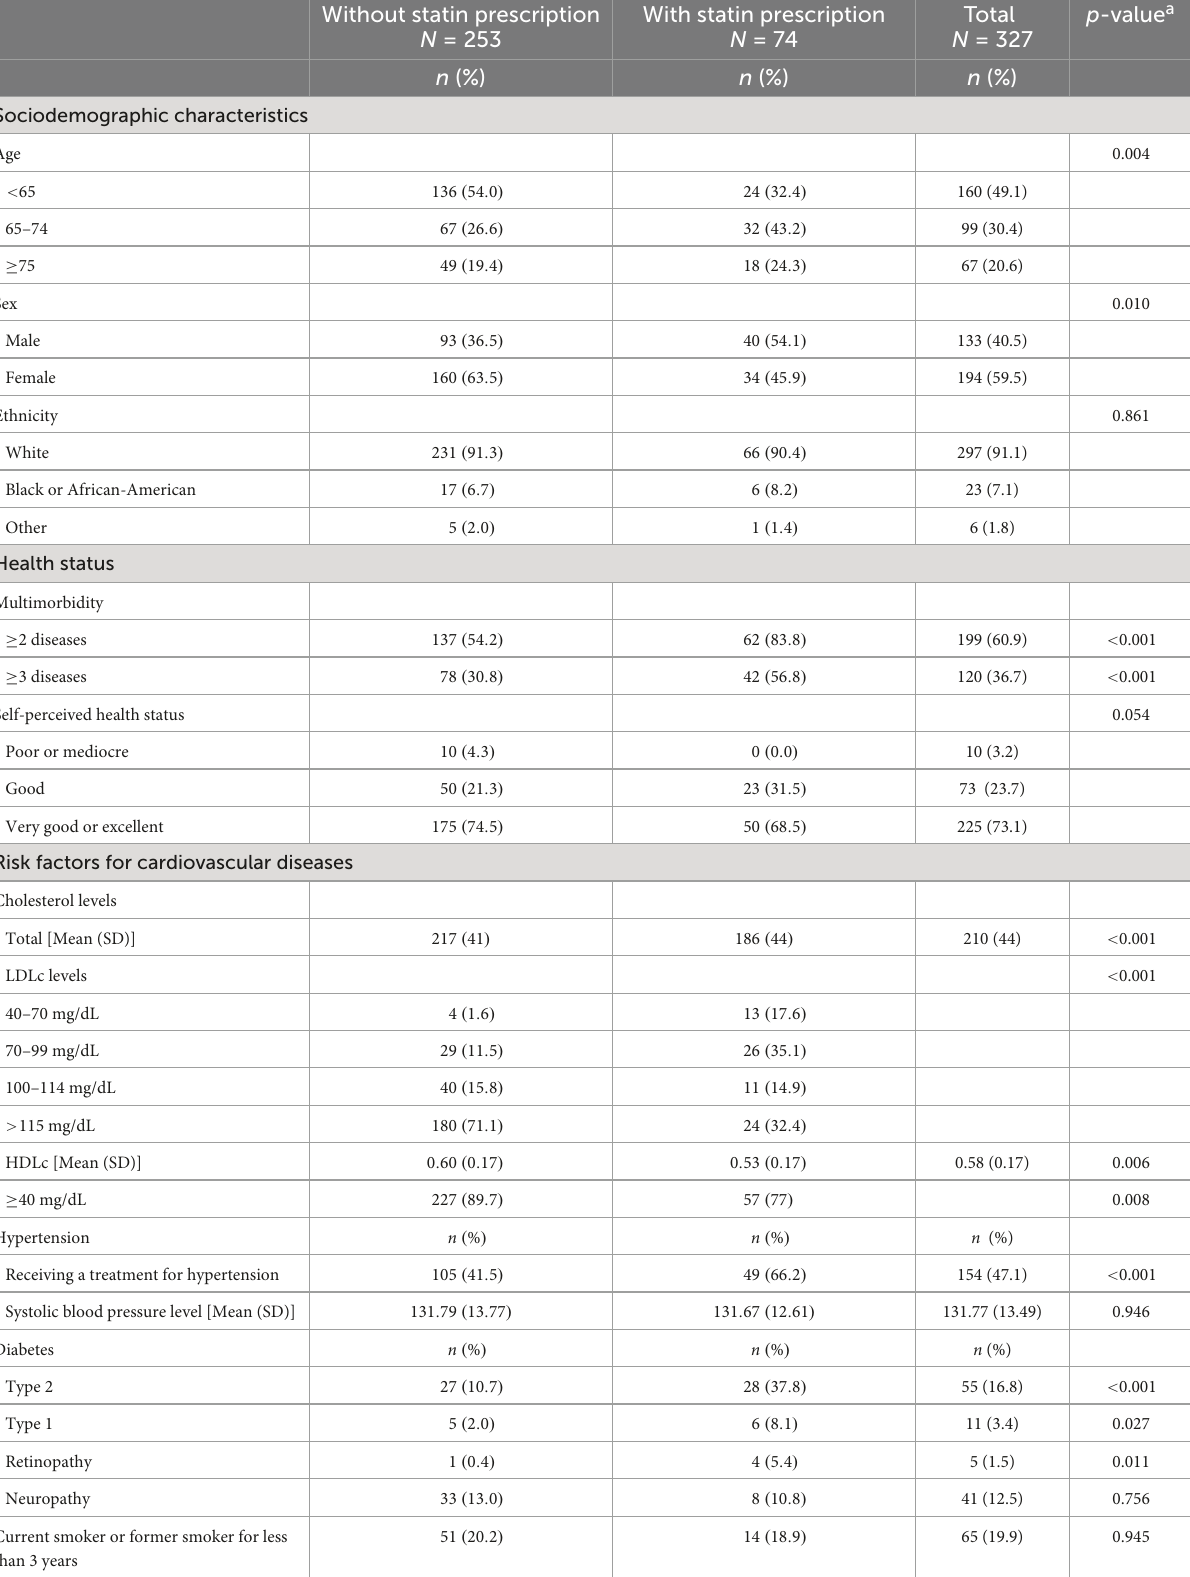
TABLE 1 Characteristics of study population, stratified by statin use ( n =